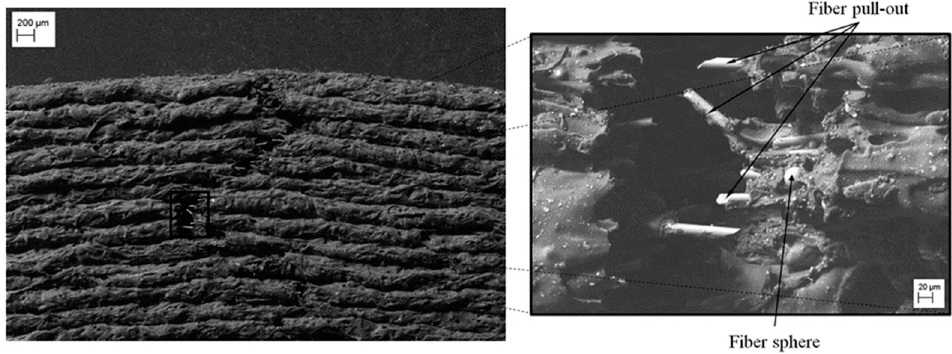
Figure 18. SEM images of X-direction specimen—lateral view.